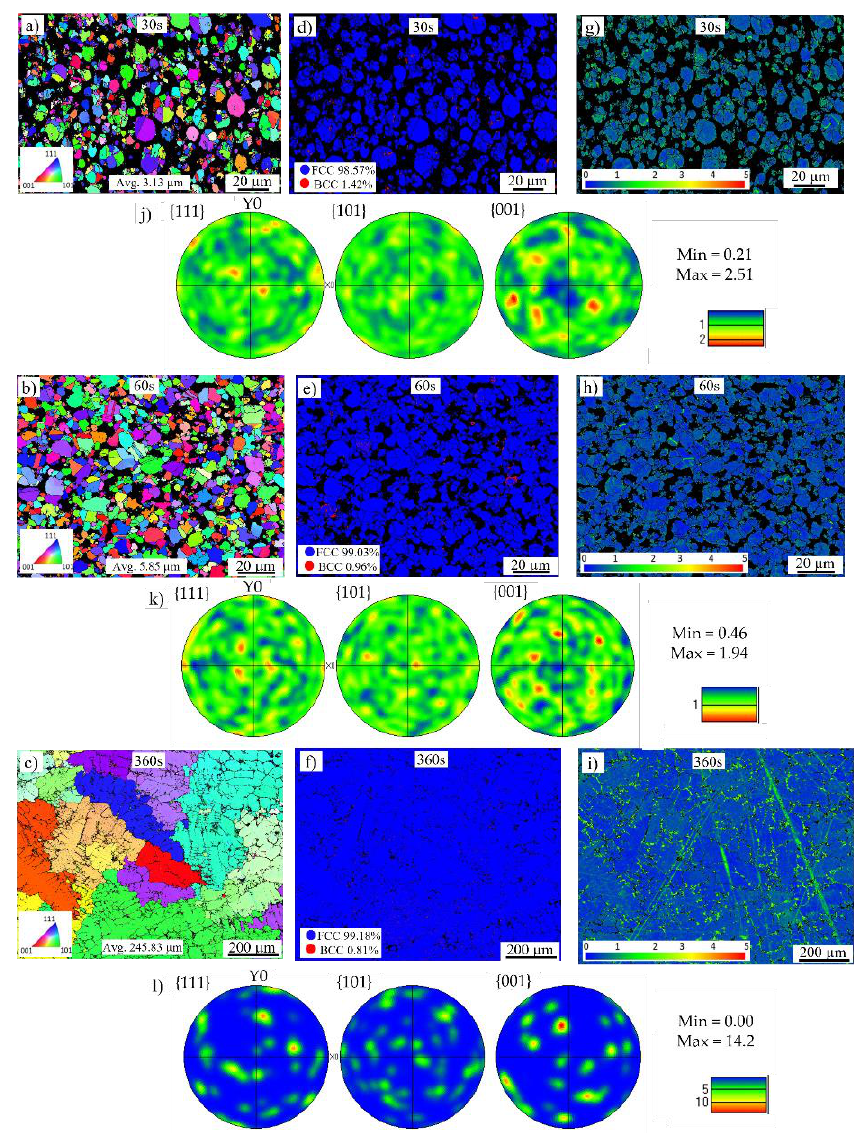
Figure 11. EBSD maps of the vacuum sintered specimens after ( a ) 30 s, ( b ) 60 s, and ( c ) 360 s, phase maps of the specimens after ( d ) 30 s, ( e ) 60 s, ( f ) 360 s, local misorientation maps after ( g ) 30 s, ( h ) 60 s, ( i ) 360 s and Euler pole figures after ( j ) 30 s, ( k ) 60 s, and ( l ) 360 s. The Euler pole figures in the {001}, {101}, and {111} planes are given in Figures 10j–l and 11j–l. The figures depict the texture defining the orientation of the crystals within the solid sintered mass. Initially the texture of the refractory-sintered sample is weak, with ~3.24 and 1.92 times random intensity after 30 s and 60 s, respectively, presenting a final isotropic randomized crystallographic texture with a maximum intensity of ~4.75 times after 240 s of soak time. For the vacuum-sintered specimens, the texture exhibits a random intensity in the {001} plane with ~2.51 and 1.94 times after 30 s and 60 s, respectively, presenting a strong texture with a maxima of ~14.2 times the uniform intensity after a sintering